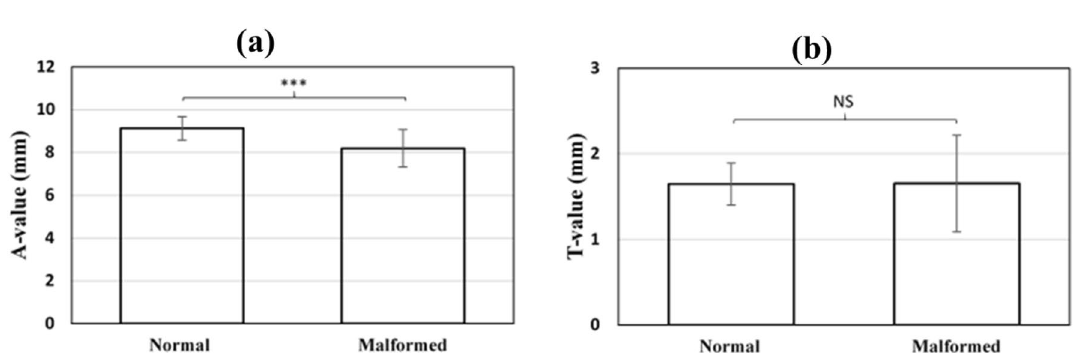
Figure 3. Histogram showing the mean ± standard deviation of A-values ( a ), and C-values ( b ), of normal versus malformed cochleae captured from CT images used in this study. Asterisks indicate statistical significance where * p < 0.05; ** p < 0.01; and *** p < 0.001.